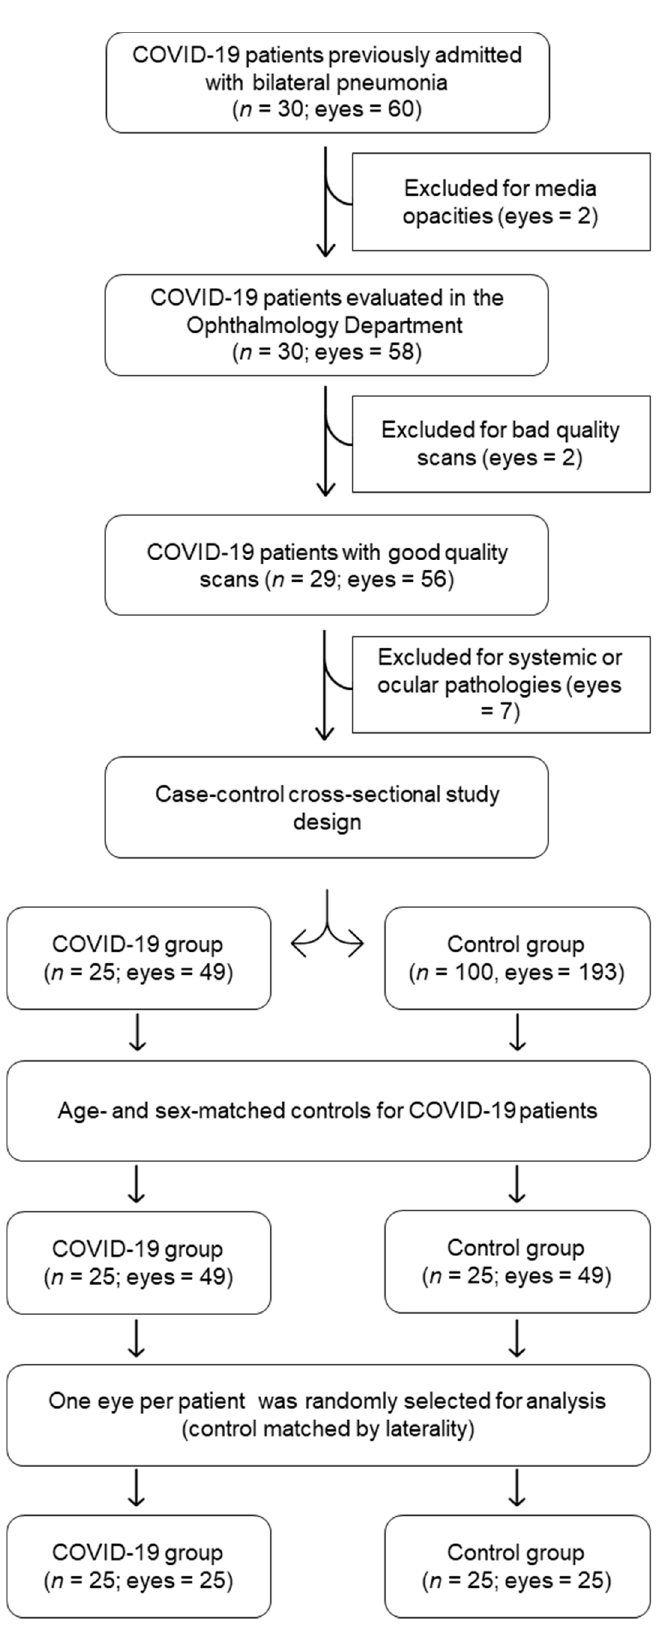
Figure 1. Consolidated standard for reporting trials (CONSORT)-style flow chart describing included and excluded eyes in the study.